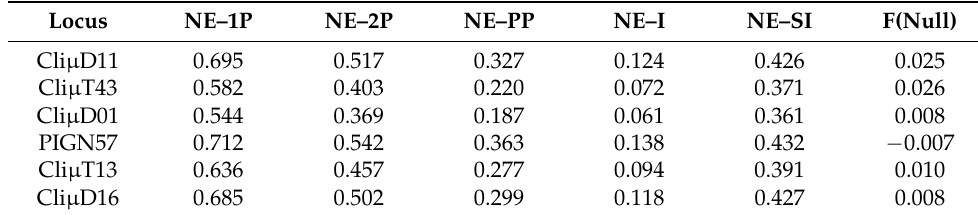
Table 3. Parentage testing indices across 17 microsatellite